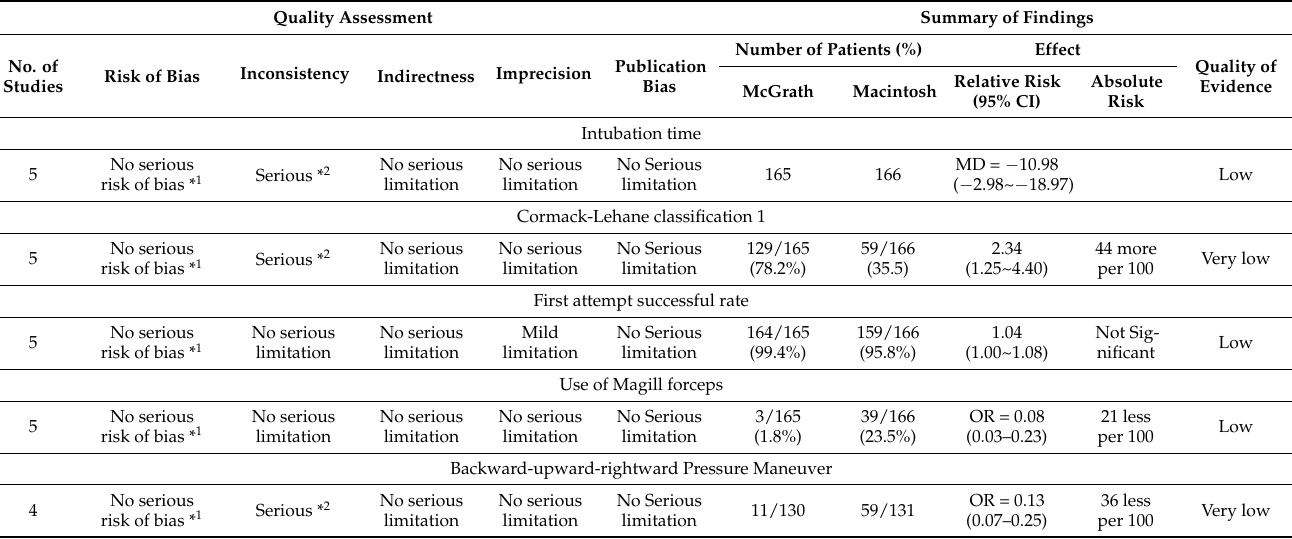
Table 2. GRADE Evidence Profiles: McGrath for nasotracheal